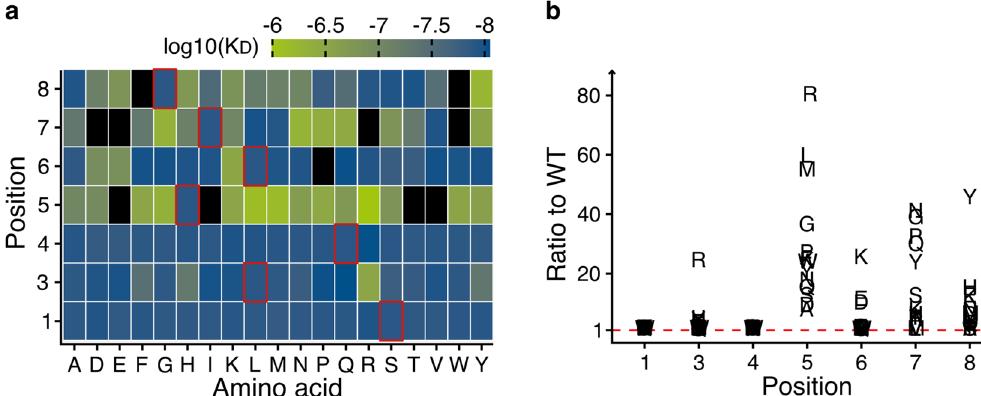
Figure 3. ( a ) Heat map of the K D values obtained from the positional scanning peptide library of the WT peptide (SLLQHLIGL). High K D are illustrated in green and lower K D values are illustrated in blue. Positions that are identical to the WT peptide sequence are highlighted with red boarders. Black tiles mean that no K D value could be determined. ( b ) Sequence plot of the K D values from the scanning peptide library. All K D values in both figures are illustrated as weighted means across all replicates. The number of replicates as well as the exact K D values for each peptide is provided in the Supplementary Data S1.